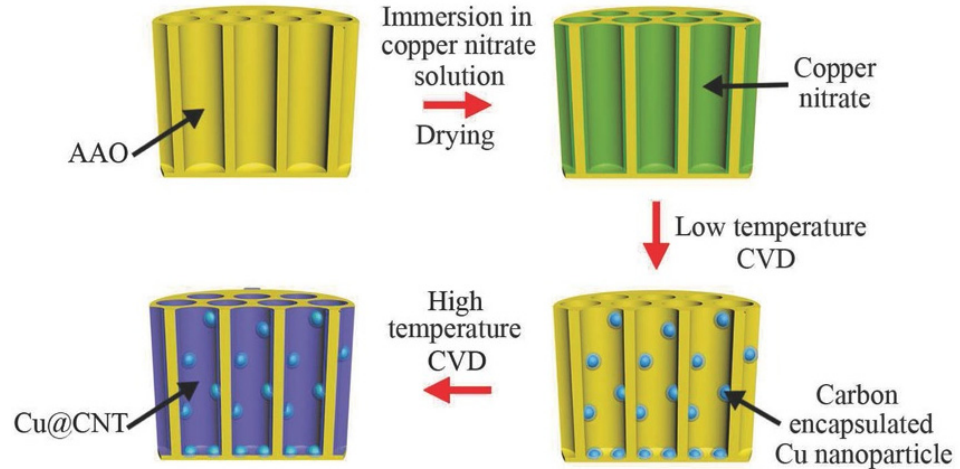
Figure 33. Schematic illustration of the procedure implemented by Zhao et al. [263] of Cu NPs embedded CNTs grown on PAA templates. Reprinted with permission from Ref. [263]. Copyright © 2023 WILEY-VCH Verlag GmbH & Co. kGaA, Weinheim.